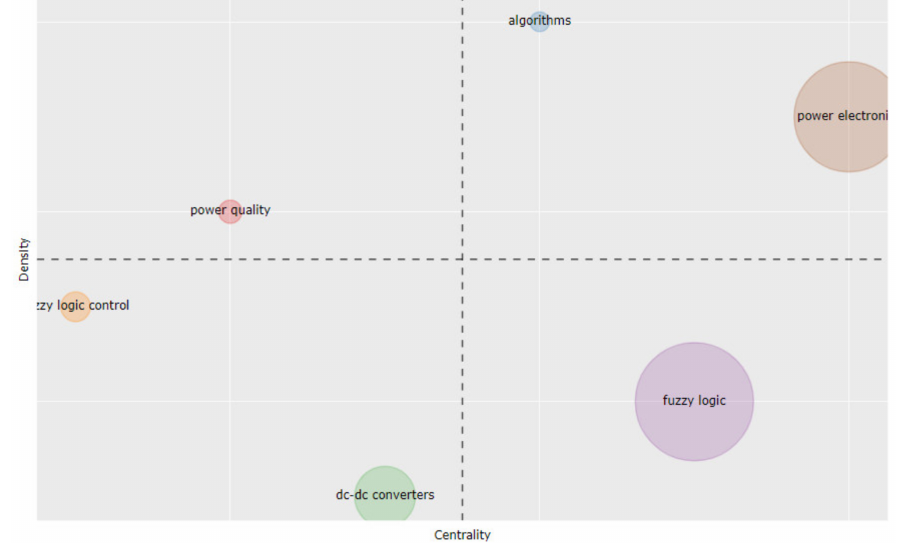
Figure 20. Thematic map, based on keywords